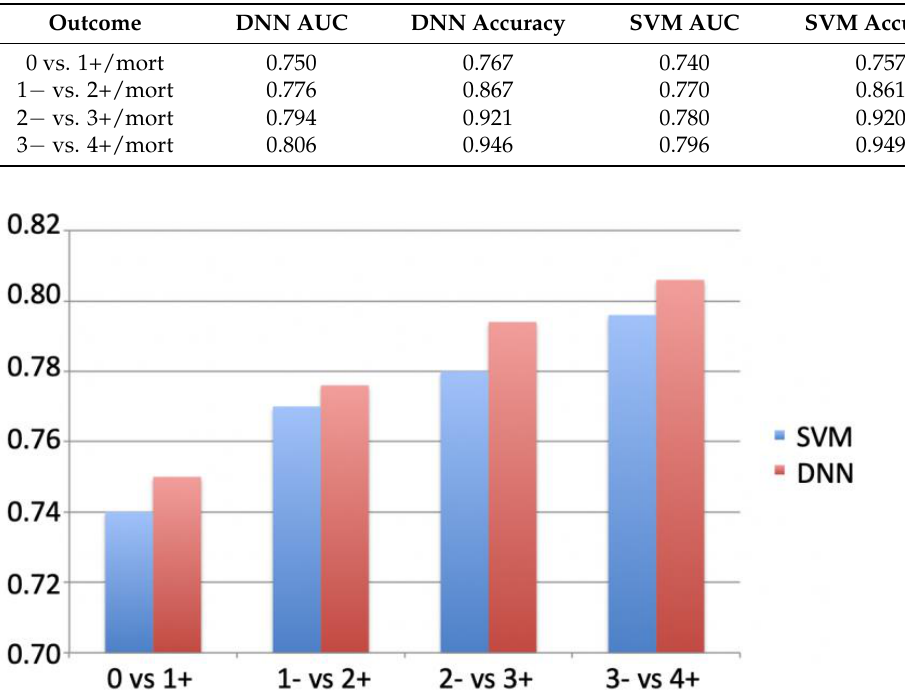
Figure 3. AUCs of the DNN model and SVM model.